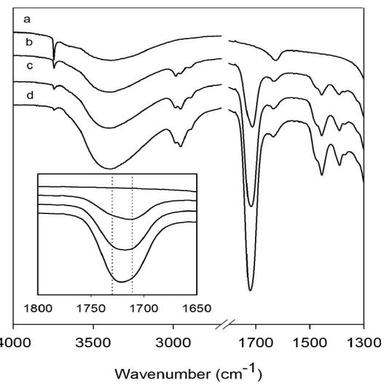
FTIR-ATR spectra of S(100)48 (a), S(100)48-PHEMA-15 (b), S(100)48- PHEMA-30 (c) and S(100)48-PHEMA-45 (d). The carbonyl band evolution is highlighted in inset for the respective spectra.